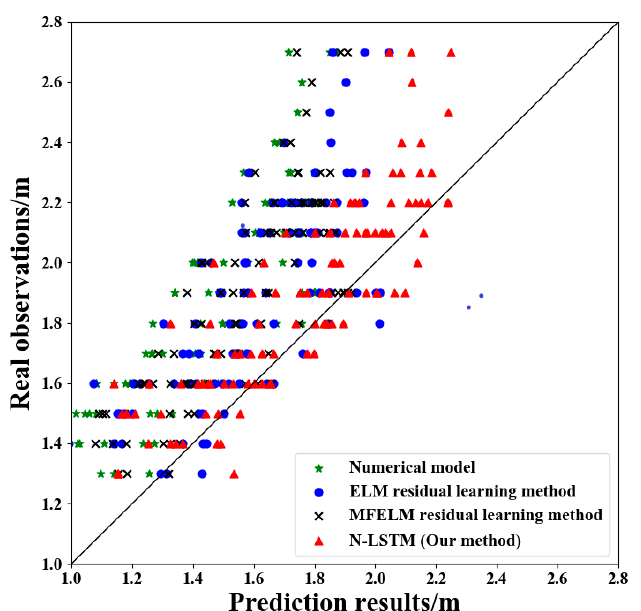
100% accuracy. The scattered points close to the diagonal reflect accurate predictions and those far from the diagonal inaccurate ones. In Figure 7, the numerical model prediction results are concentrated on the upper left of the diagonal. It means that the correct results for the numerical model are always smaller than the real observations. The prediction results obtained by our method are closer to the diagonal than the results obtained by the ELM residual learning method and the MFELM residual learning method. In particular, the predictions of the numerical model have a large deviation and the prediction effectiveness of the other two ELM methods is poor when the significant wave heights are higher than 2 m. In contrast, our method maintains a good prediction of this situation.